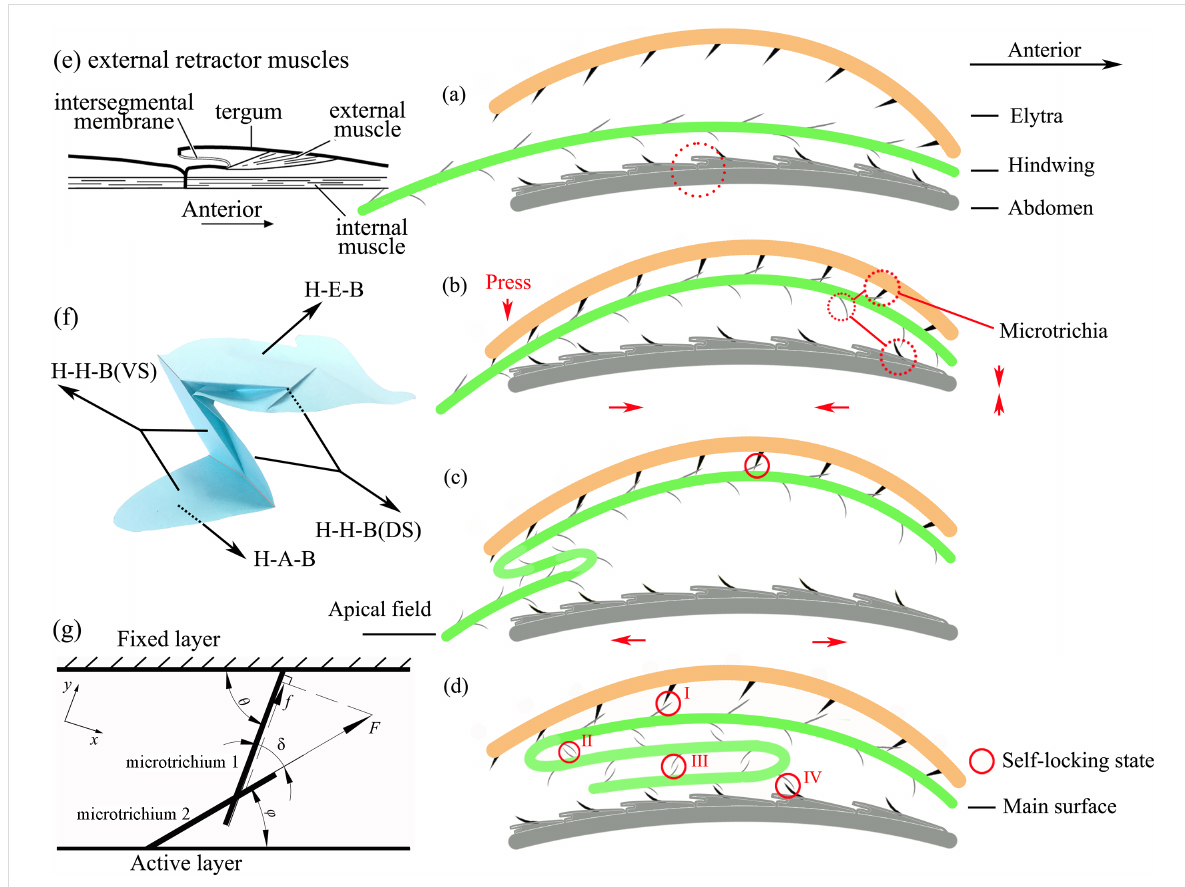
Figure 7: The interlocking model of hindwings of the H. axyridis. (a–d) show the interlocking model of a H. axyridis hindwing corresponding to Figure 6a–g. (e) Diagram of the dorsal longitudinal musculature in an abdominal segment and the typical arrangement of external and internal muscles, both of which act as retractors [27]. (f) Schematic diagram of a folded hindwing. H-E-B is the binding of hindwing and elytra; H-H-B (DS) is the binding of the hindwing to itself on the DS; H-H-B (VS) is the binding of hindwing to itself on the VS; H-A-B is the binding between the hindwing and the abdomen. (g) Schematic of interaction forces of microtrichia during folding